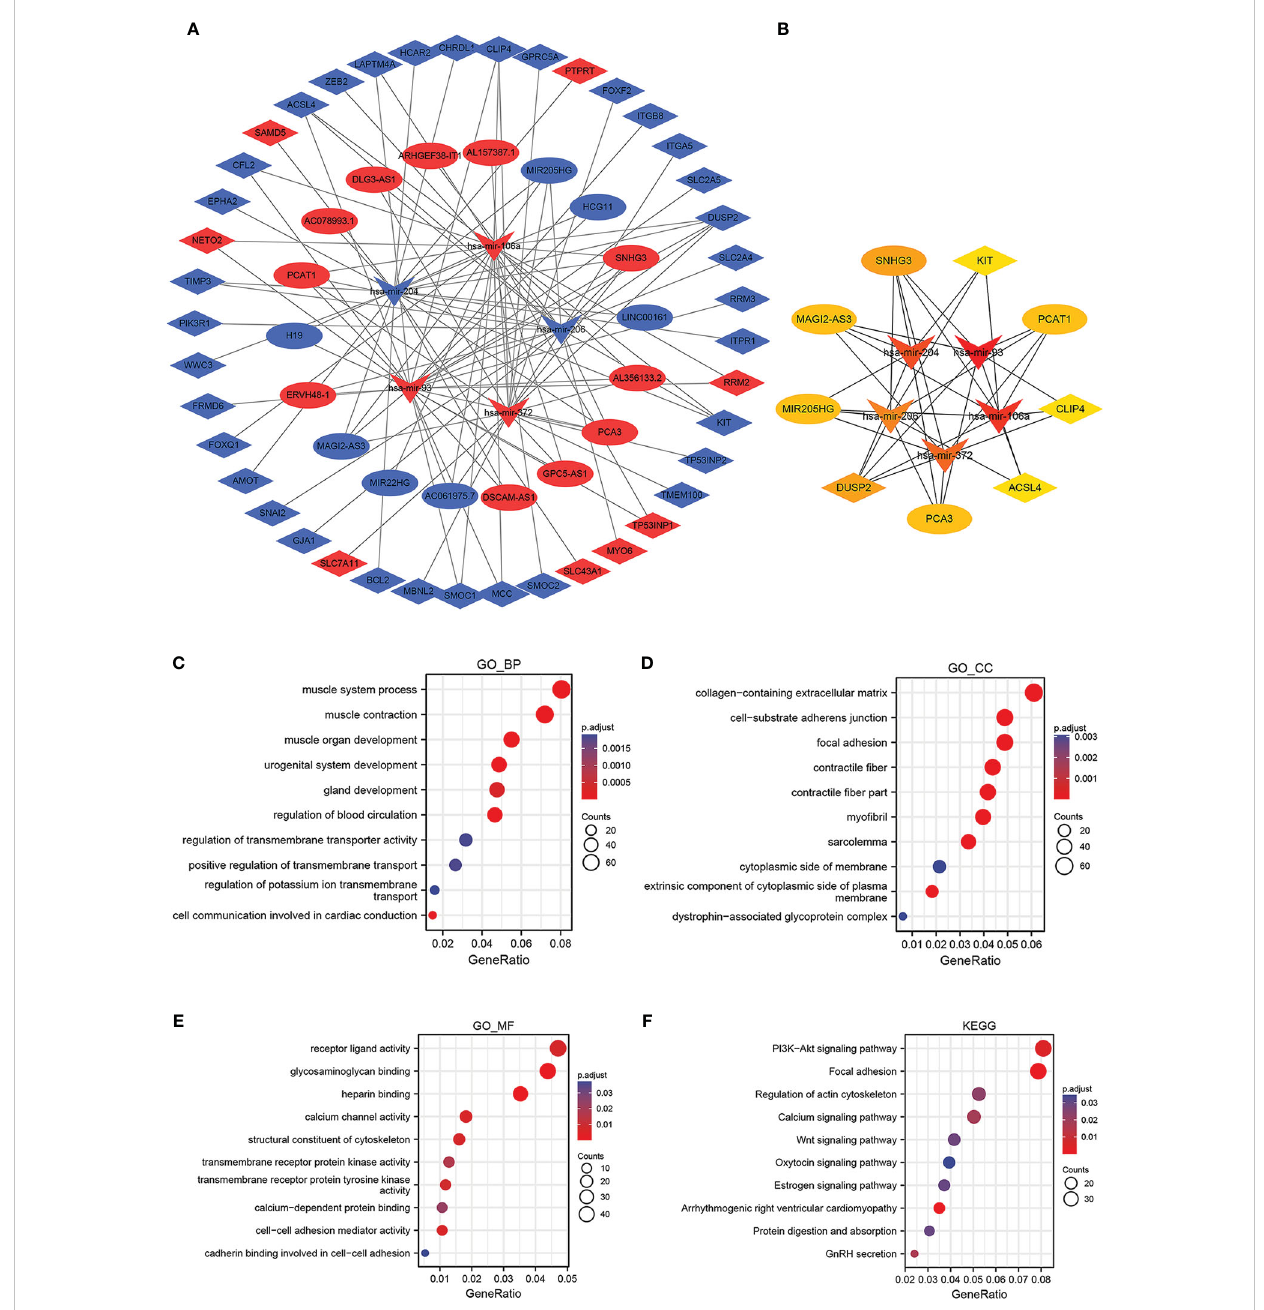
FIGURE 4 Construction and functional enrichment analysis of the lncRNA – miRNA – mRNA triple regulatory network. The ellipses denote lncRNAs, diamonds denote mRNAs, and round rectangles denote miRNAs. (A) The triple regulatory network in PCa. (B) Thirteen hub genes are in this network with a score of >2. (C – F) Functional enrichment analysis (GO and KEGG) of the DEmRNAs in the